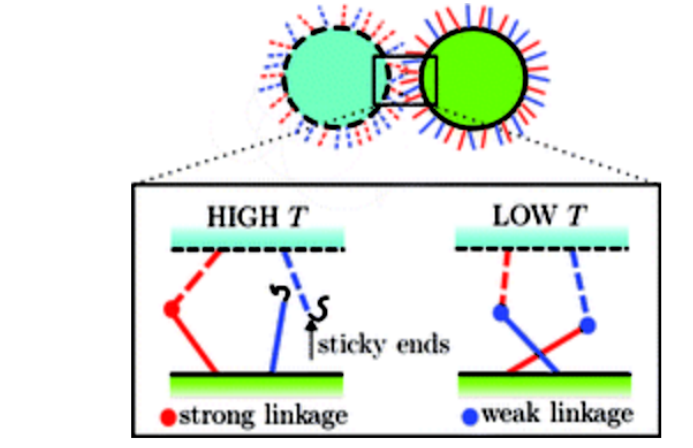
Figure 6. Reprinted with permission from Mongnetti et al. [111], shows the proposed scheme to introduce competing interactions. Copyright 2005 Royal society of Chemistry.